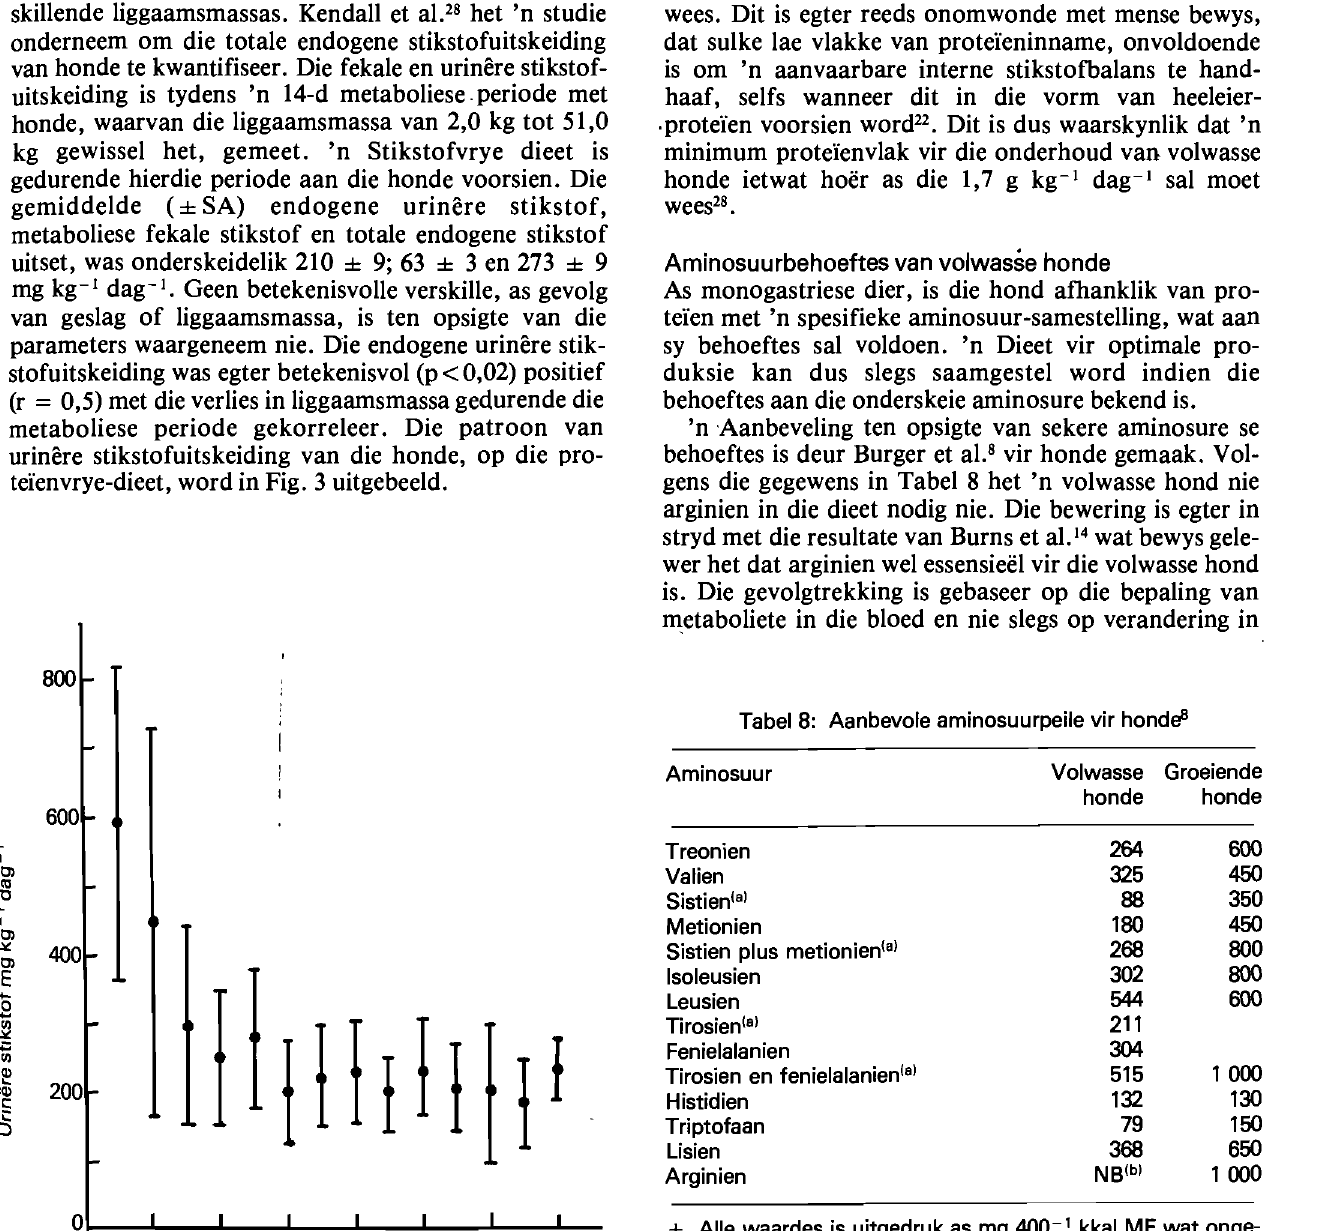
Fig. 3: Urinflre stikstofpatroon van honde op 'n protei"envrye dieet2B